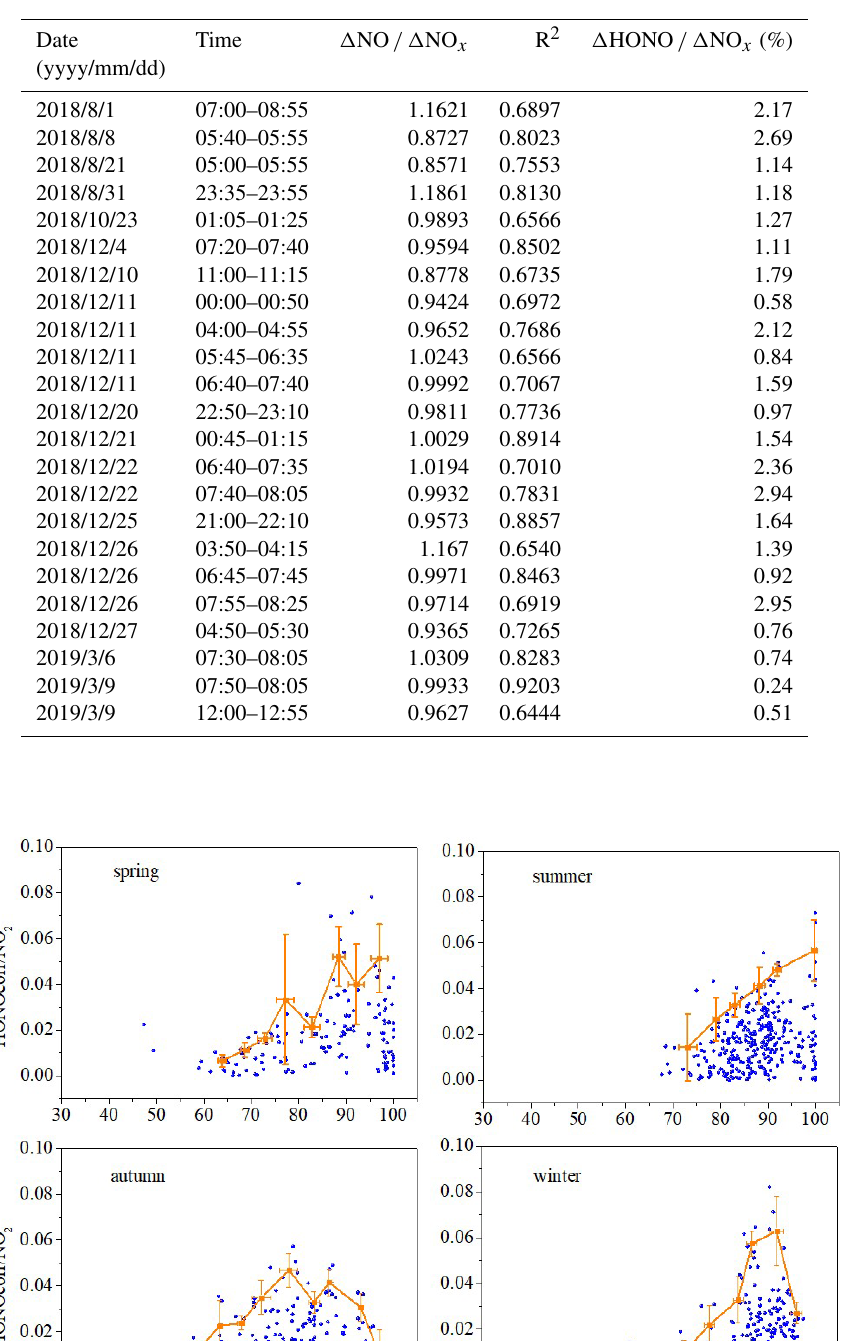
Table 2. Emission ratios of fresh vehicle plumes (cid:49) HONO /(cid:49) NO x .